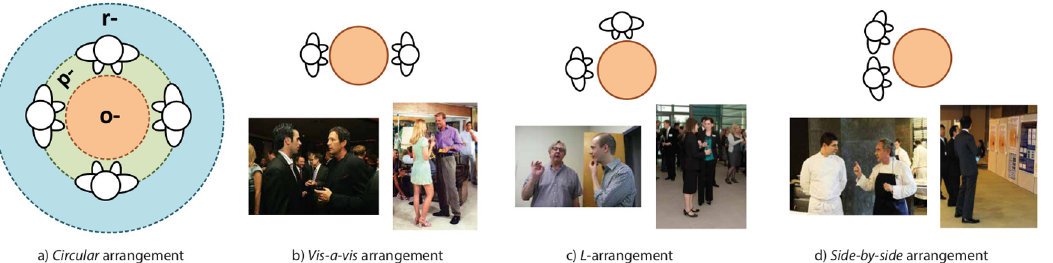
Fig 4. Structure of an F-formation and examples of F-formation arrangements. a) Schematization of the three spaces of an F-formation: starting from the centre, o-space , p-space and r-space . b-d) Three examples of F-formation arrangements: for each one of them, one picture highlights the head and shoulder pose, the other shows the lower body posture. For a picture of circular F-formation, see also Fig 1.